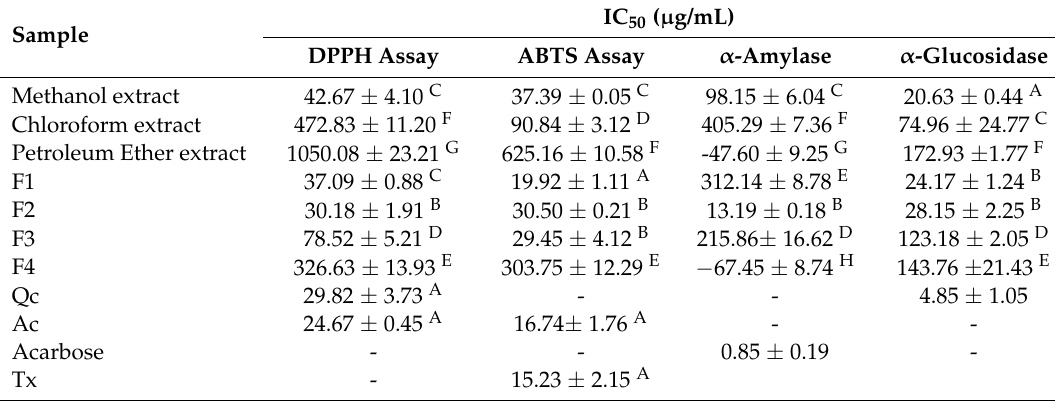
Table 2. Radical scavenging and enzyme inhibitory activity of extracts and methanol fractions from Entada spiralis stem